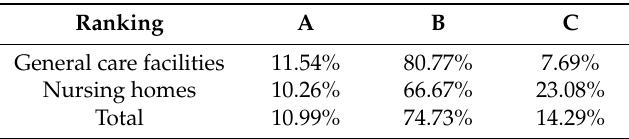
Table 4. Summary of accreditation results.